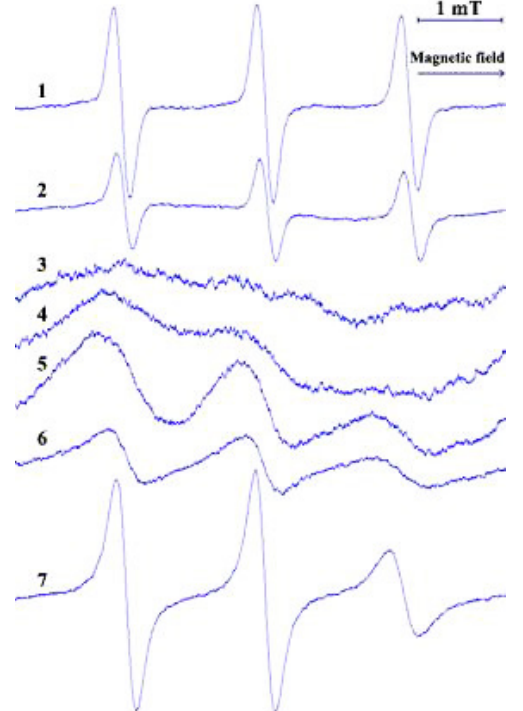
Fig. 10. EPR spectra of probe 1 in water (1) and aqueous solutions of SLS at concentrations: 2 – 0.0025 %; 3 – 0.005 %; 4– 0.10 %; 5 – 0.125 %;